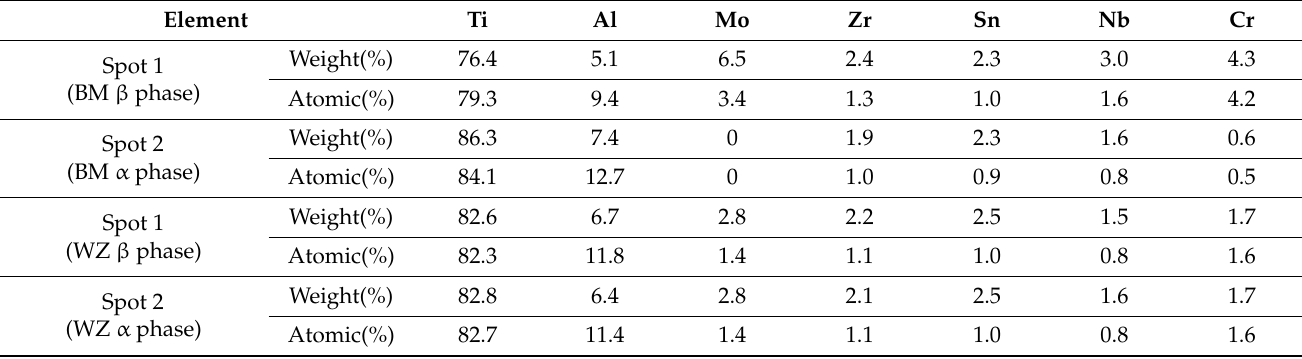
points of WZ and corresponding EDS spectrum distributions. Table 3. Ratio of elements at different test spots in BM and